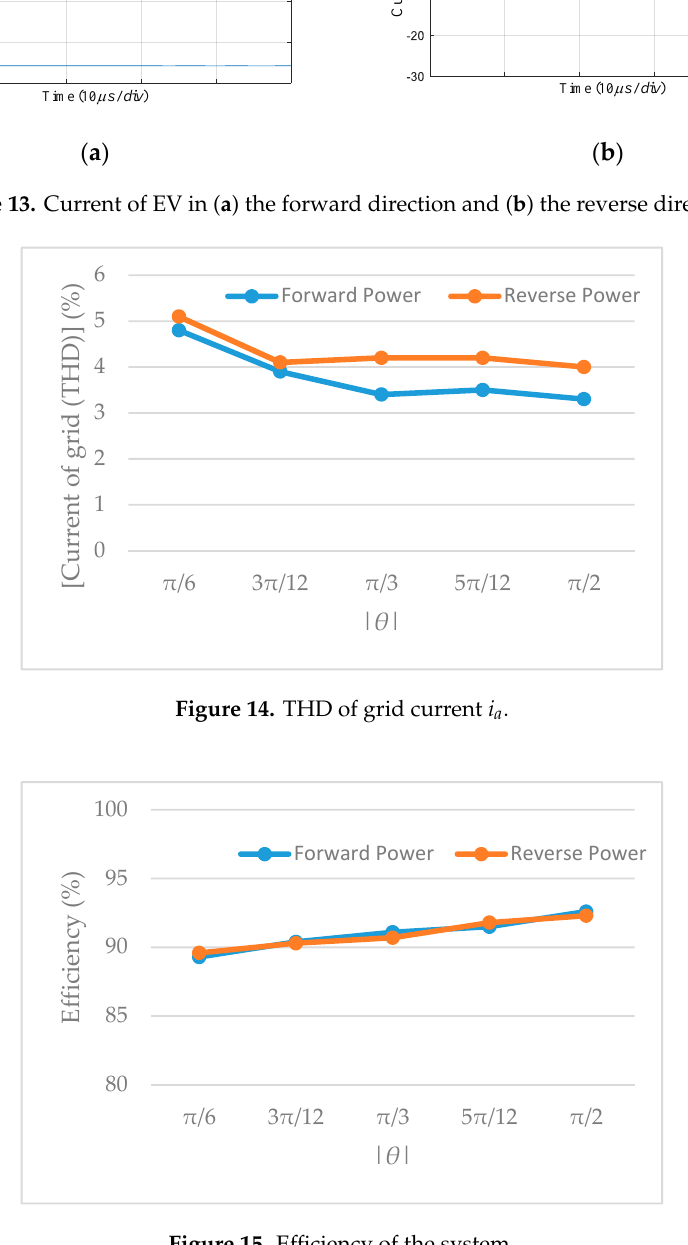
Figure 13. Current of EV in ( a ) the forward direction and ( b ) the reverse direction.